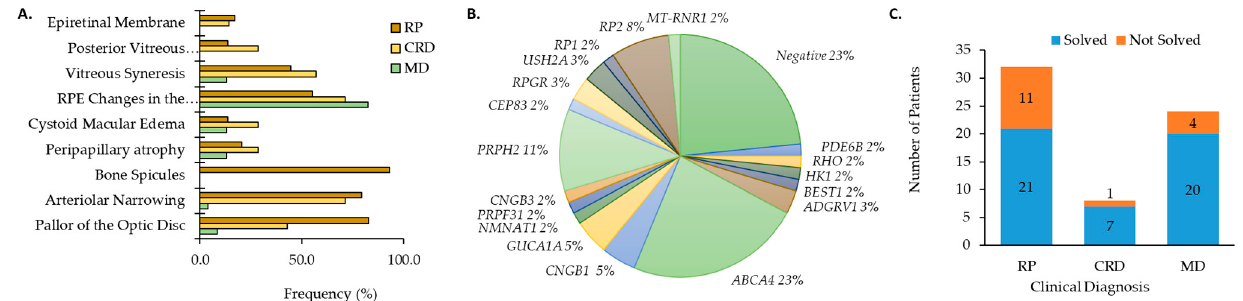
Figure 1. Clinical characteristics for patients with ( A ) cone rod dystrophy (CRD) and retinitis pig- mentosa (RP) and macular dystrophy (MD). ( B ) Distribution of genes causative for ocular disease by number of patients (%). ( C ) The number of genetically solved cases subset by clinical